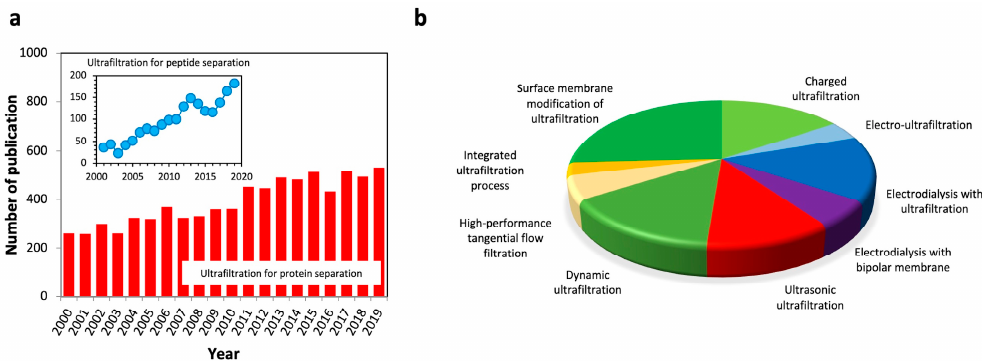
Figure 1. ( a ) Number of publications associated with “protein ultrafiltration” and “peptide ultrafiltration” as indexed by Scopus [TITLE-ABS-KEY (terms)]. ( b ) Research focus in ultrafiltration of protein, divided by various [KEY (terms)] of Scopus showed in the legend. Table 1. Significant ultrafiltration (UF)-assisted separation process of protein hydrolysates with expressed bioactivities from plant